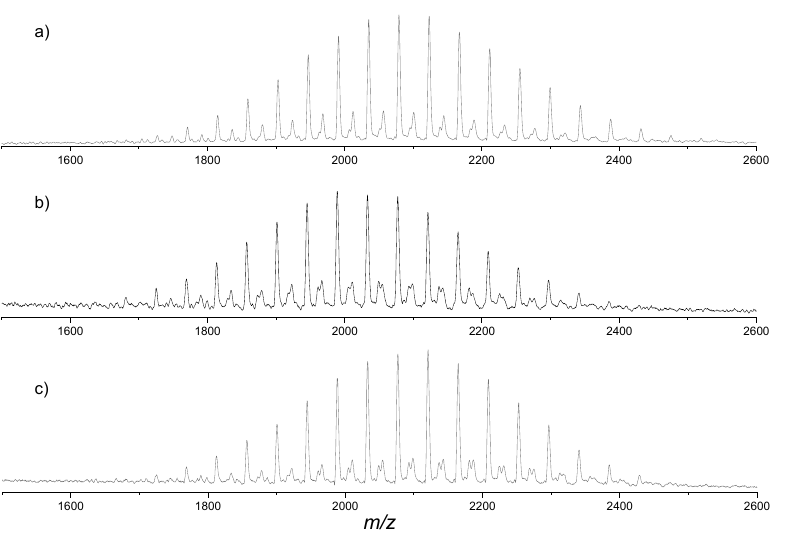
Figure 10. MALDI-TOF mass spectra of the samples: parent ( a ), StarP-R ( b ), and StarP-F ( c ).